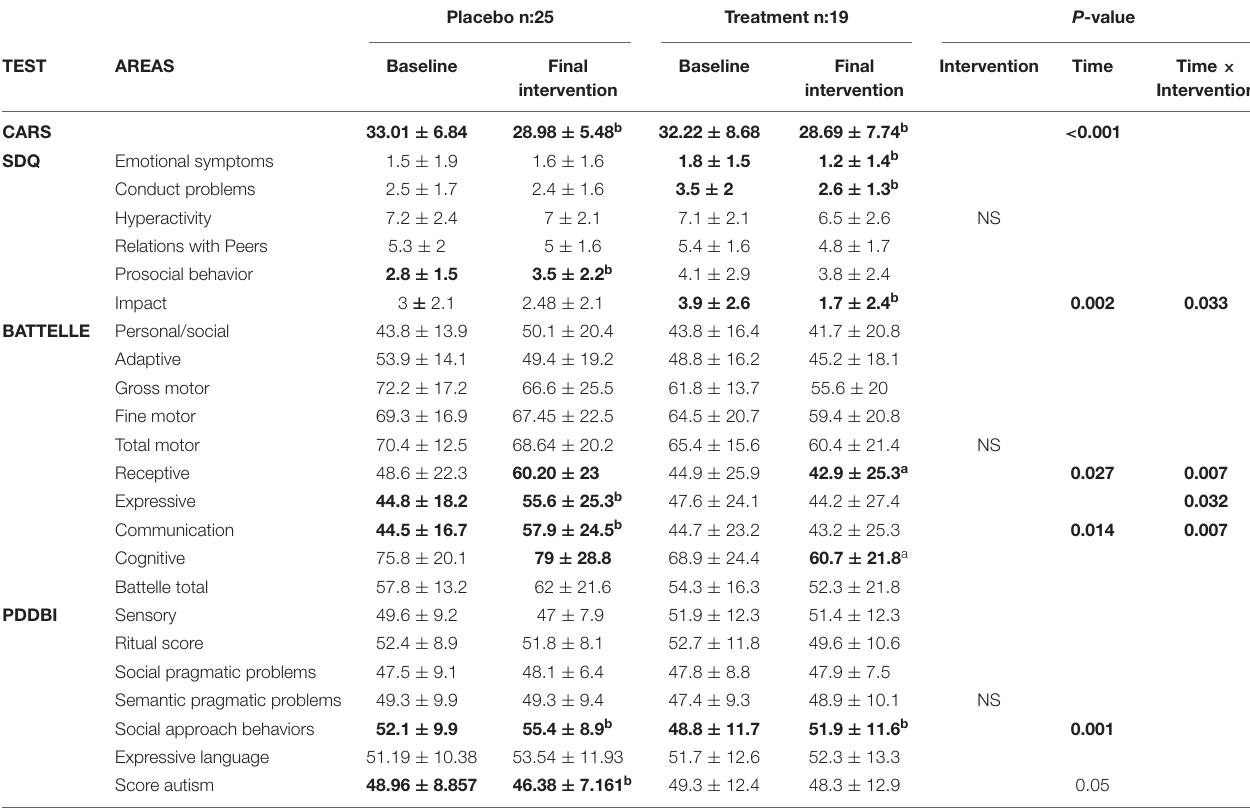
TABLE 6 | Clinical test for ASD children evaluation at baseline and after 6 months with DHA intervention or placebo. Placebo n:25 Treatment n:19 P